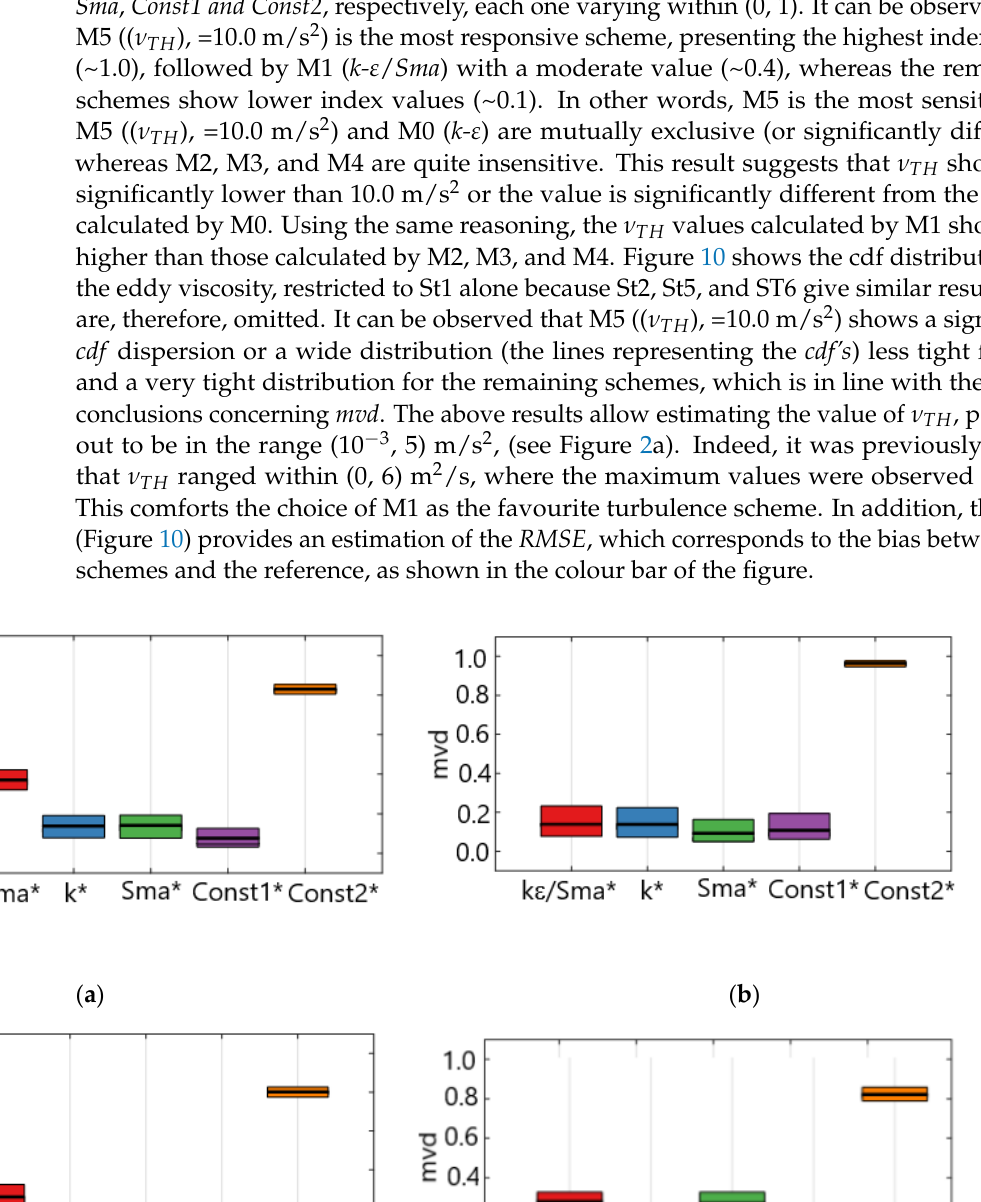
Figure 10. Cdf for the eddy viscosity ( 𝜈 𝑇 ), for St1 Figure 11a – d shows the mvd index for the salinity for the same stations as previously. St1 shows a low value of the index (<0.4) for all schemes, depicting low sensitivity, while